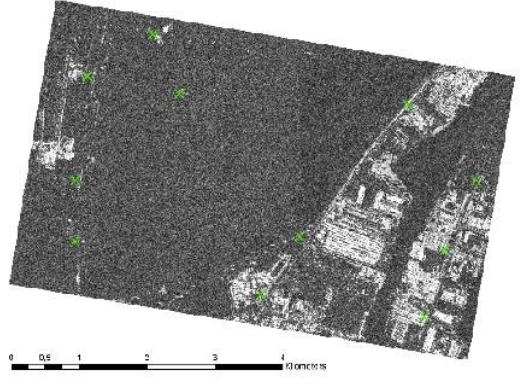
Figure 8: Coherence map of the TerraSAR-X ST pair 03/06/2015-31/01/2016. In green, the location of the GPS points.